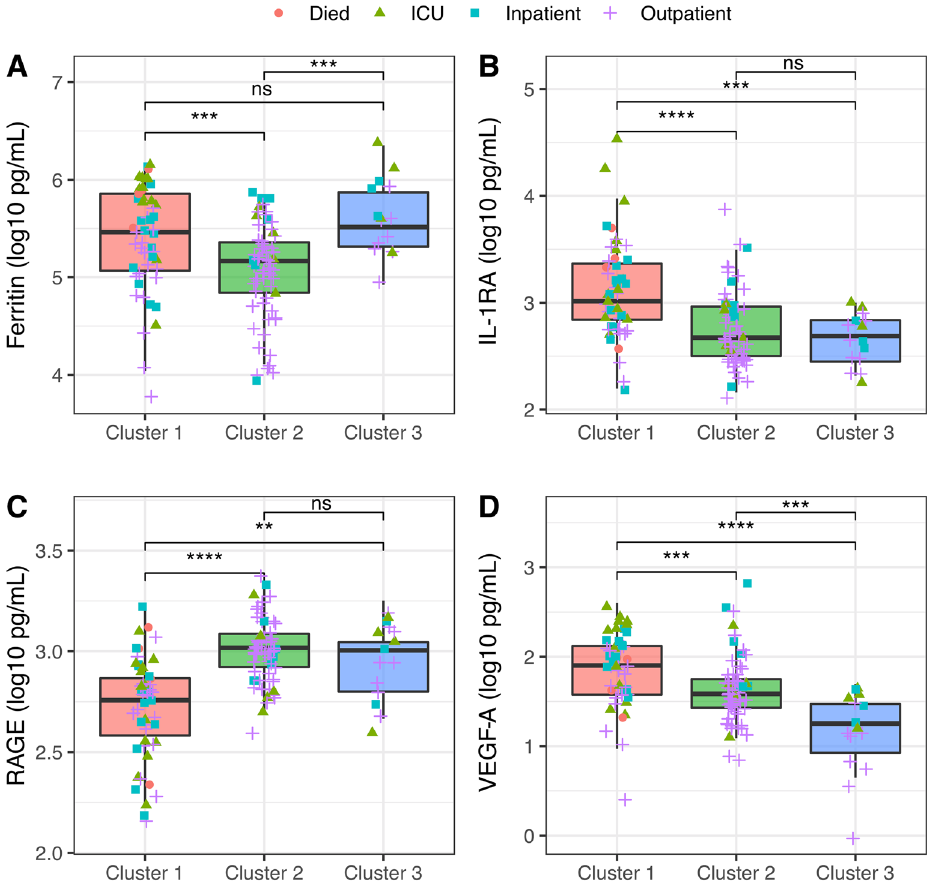
Figure 3. Box plots of markers selected in stepwise regression to identify characteristic biomarkers of each cluster: Ferritin ( A ), IL1RA ( B ), RAGE ( C ), and VEGFA ( D ) by cluster. Kruskal–Wallis test performed comparing analyte levels between clusters. **p ≤ 0.01; ***p ≤ 0.001; ****p ≤